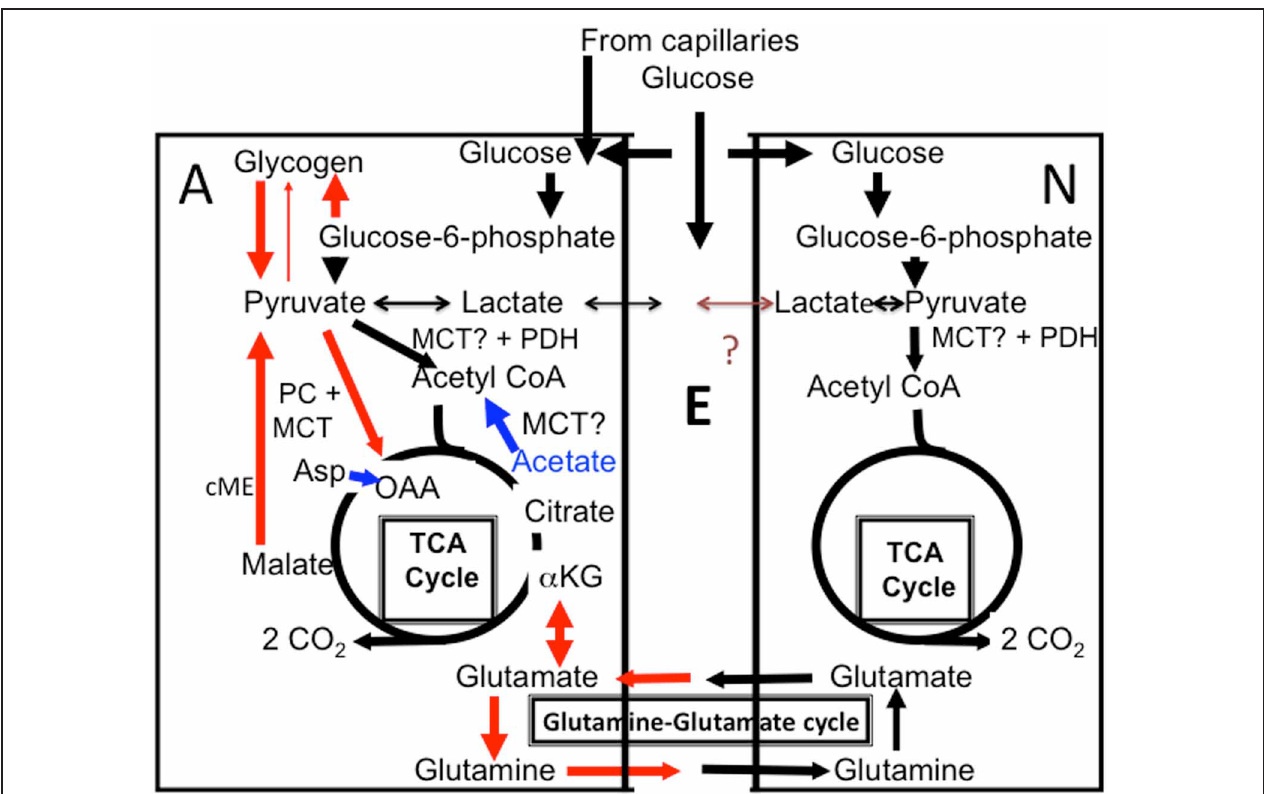
FIGURE 1 | Cartoon of glucose metabolism in astrocytes (A, left) and neurons (N, right), with extracellular space shown as E. Glucose is accumulated both in neurons and astrocytes and metabolized via glucose-6-phosphate to pyruvate and in astrocytes also used for glycogen synthesis. Pyruvate is mainly metabolized via pyruvate dehydrogenase (PDH) to acetyl coenzyme A (acetyl CoA) that, in the mitochondrial tricarboxylic acid (TCA) cycle, condenses with oxaloacetate (OAA) to form citrate (pathway shown in black). Lactate can also be formed from pyruvate. Some of this lactate may be released from the cell, although glycogen-derived lactate may be formed and released slowly in vivo . According to some of the authors discussed in the present “perspective” release of glycogen-derived lactate may be followed by its uptake into neurons and use as an important metabolic substrate for neurons during learning. The postulated net flux from astrocytes to neurons has never been proven and a brown question mark is shown in the Figure. Citrate is further metabolized via α -ketoglutarate ( α -KG) to eventually regenerate oxaloacetate, which condenses with another molecule of acetyl CoA, and so on. During the process two molecules of CO 2 are released. The purpose of this cycle is solely generation of ATP. In astrocytes additional pathways are also operating (red), which is a major reason for the importance of astrocytes, including astrocytic glycogenolysis. Glucose is used for synthesis of glycogen, which is metabolized to glucose-6-phosphate (by a different route than glucose and therefore selectively inhibitable by DAB), and from there by the same pathway as glucose, to pyruvate. Pyruvate can be carboxylated to form a “new” molecule of oxaloacetate, which condenses with acetyl CoA to form a “new” molecule